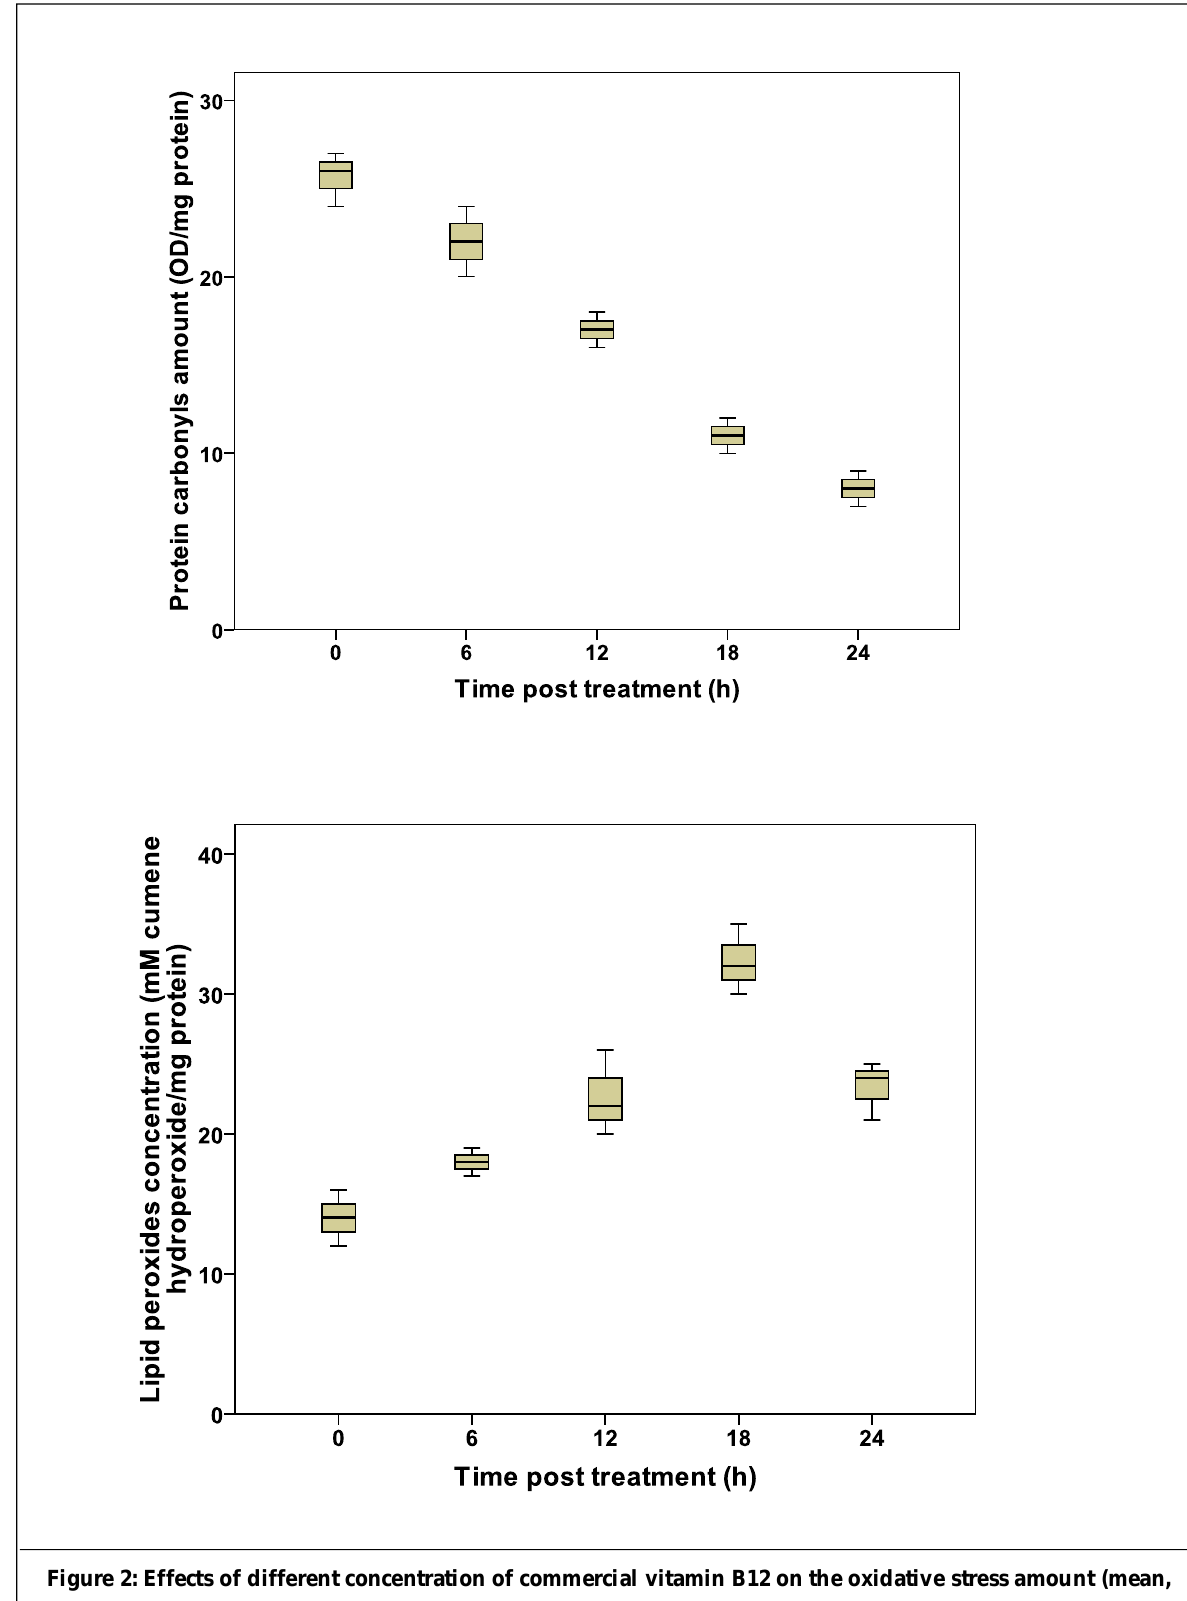
Figure 2: Effects of different concentration of commercial vitamin B12 on the oxidative stress amount (mean, P25, P75) of protein carbonyls and lipid peroxides measured in adult of Sitophilus oryzae . Adult insects were injected with different time course post injection of vitamin B12: 0, 6, 12, 18 and 24 h. ‘small letter’ at the top of the fig. report the statistical comparisons among control and vitamin B12-treated larvae at each case separately (ANOVA, Tukey2 s-b test, p <